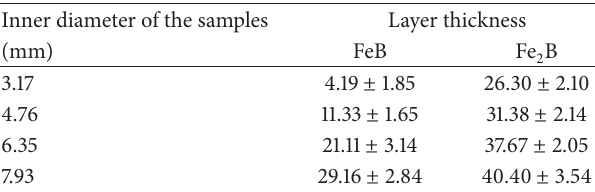
Table 2: Layer thickness as a function of the boron potential represented by the inner diameter of the samples at 1273 K and 6 h of exposure time.